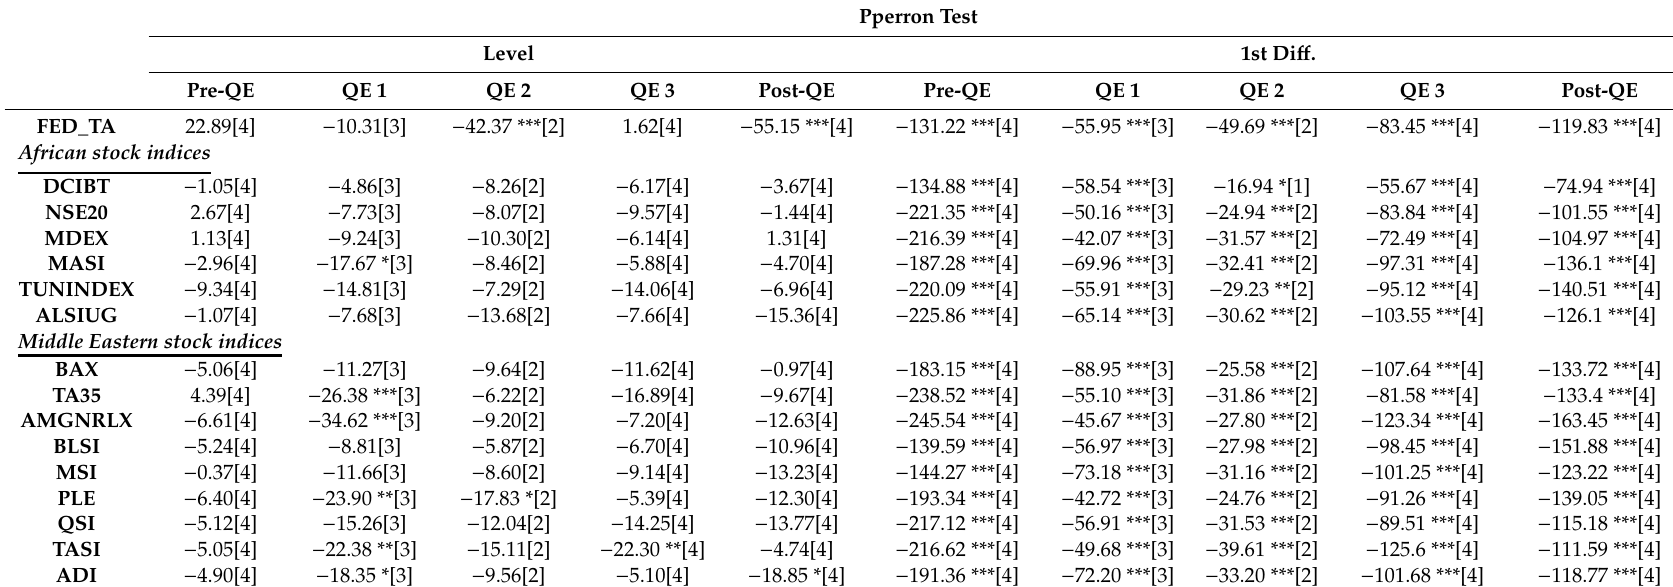
Table 4. Unit roots tests results based on the Phillips–Perron